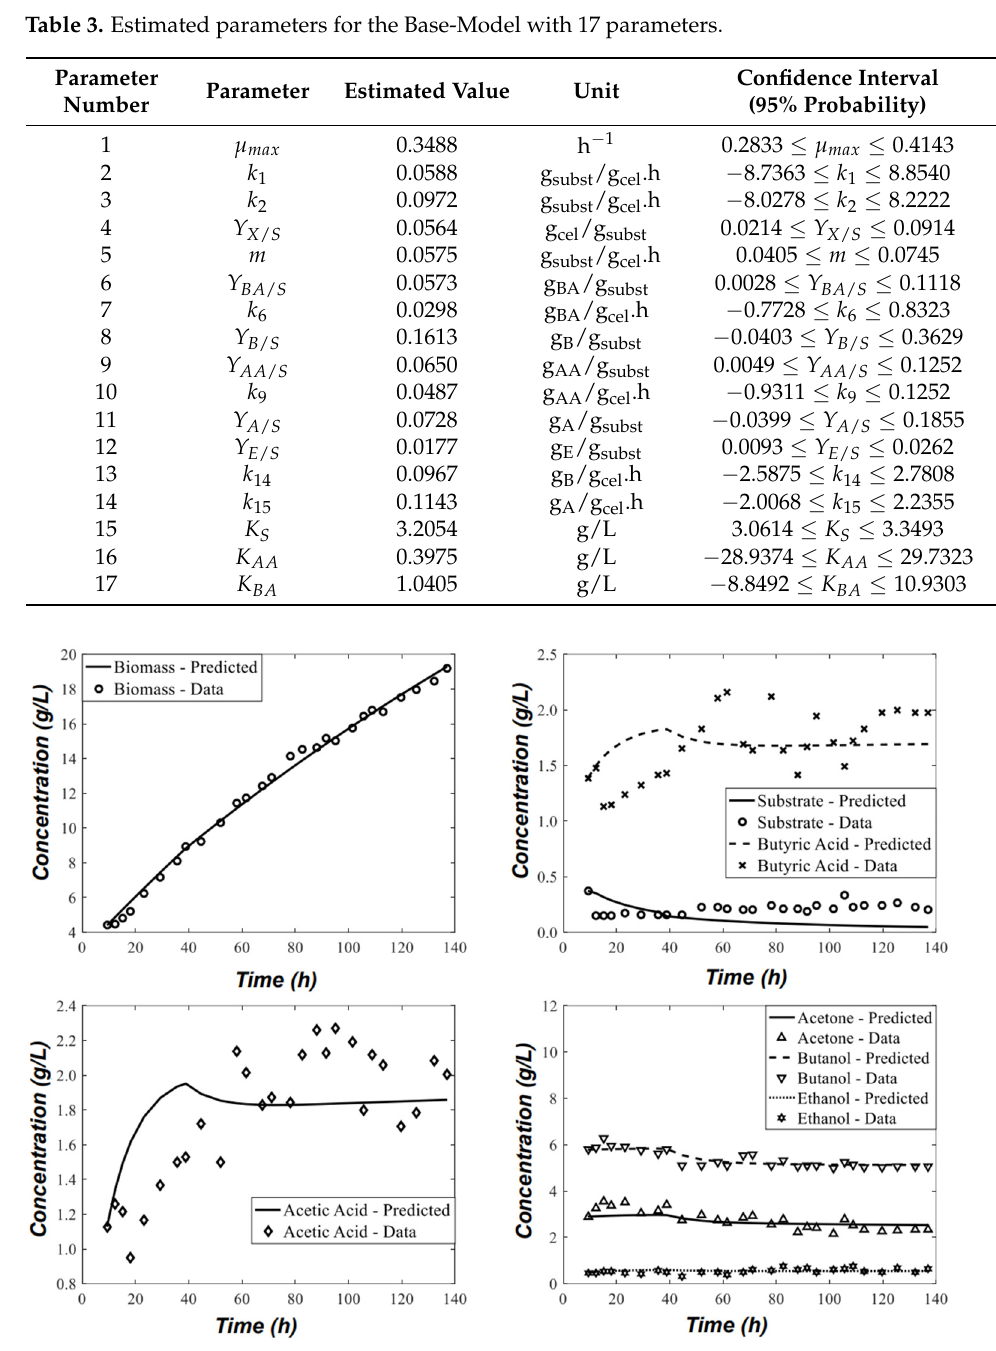
Figure 1. ABE fermentation Base-Model with 17 parameters: predicted concentration versus time against experimental values.